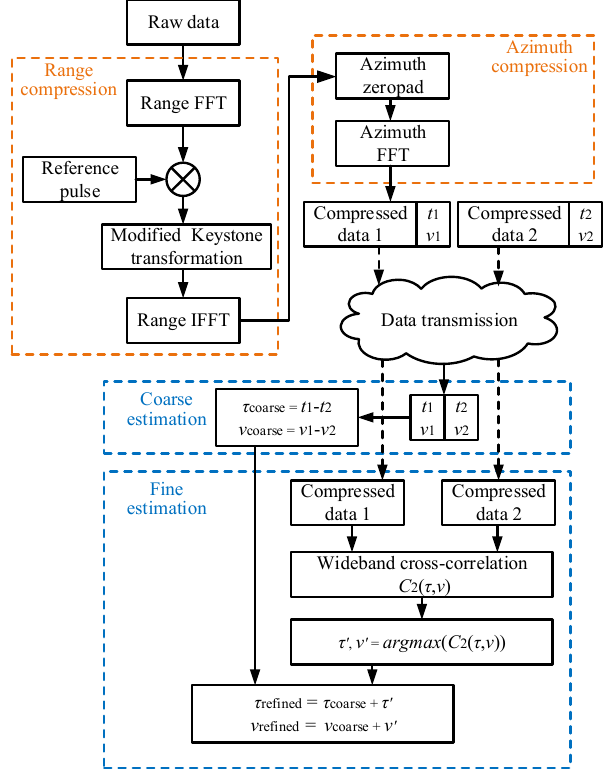
Figure 2. The flowchart of the TDOA and FDOA estimations.